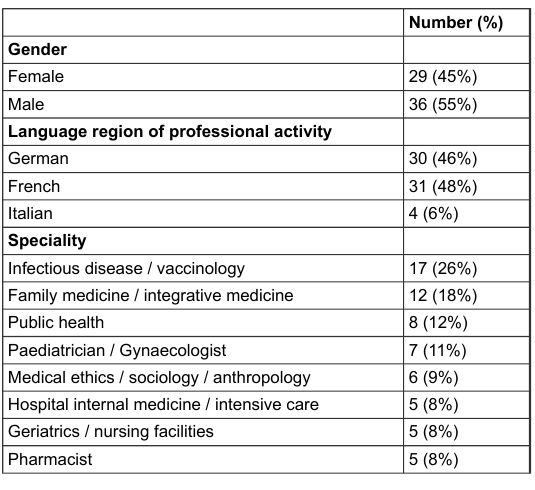
Table 1: Characteristics of study participants (n =